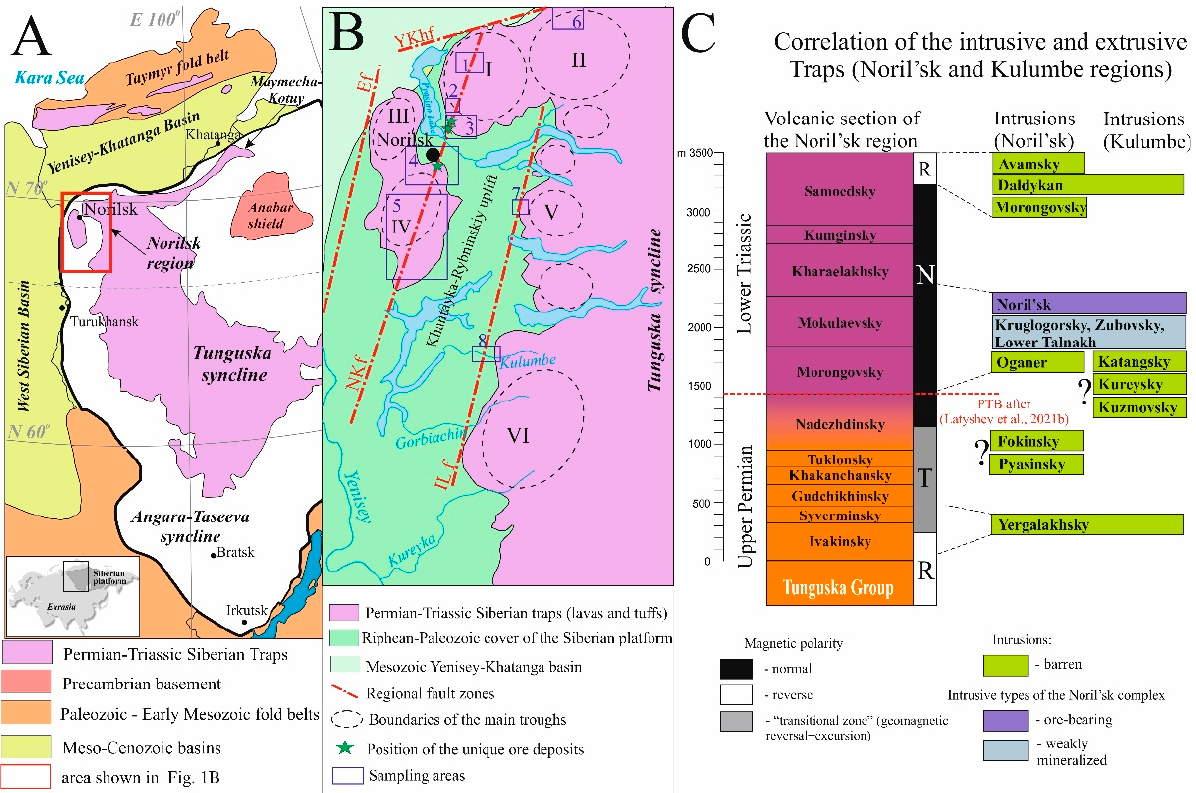
Figure 1. ( A ) Sketch map of the Siberian Traps within the Siberian platform and surrounding areas. ( B ) Position of the studied areas. Regional faults: fault,